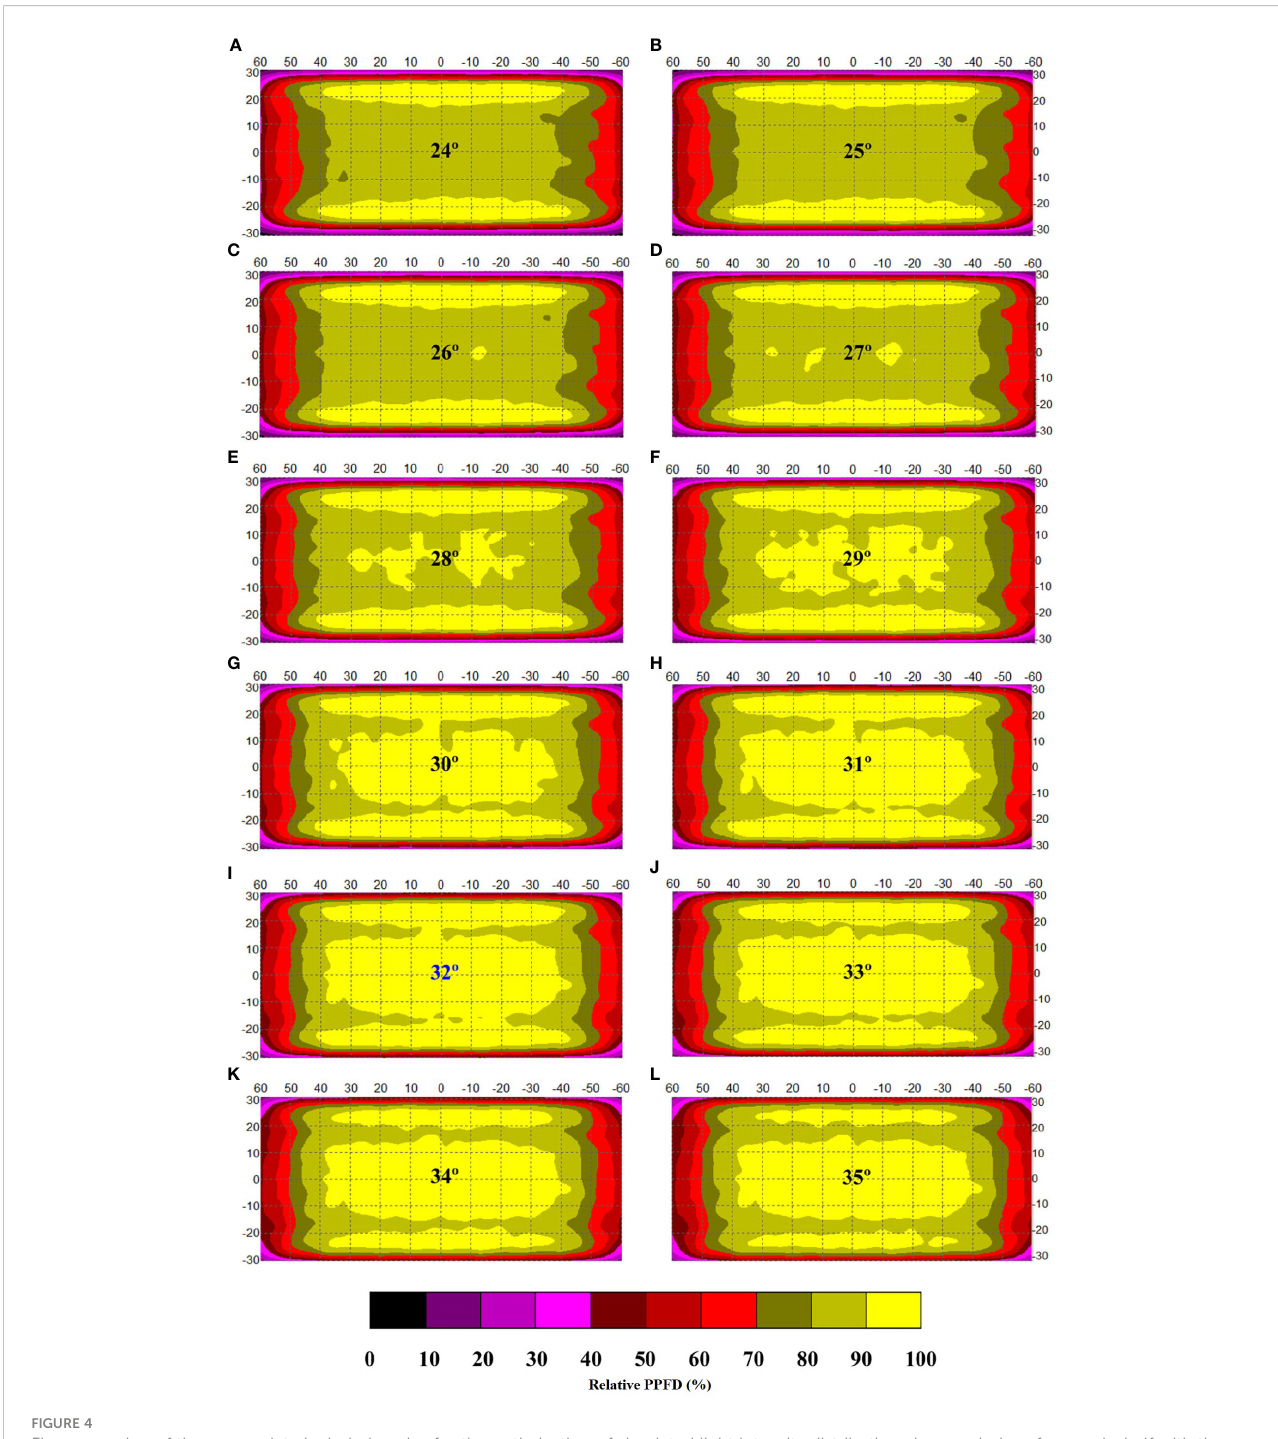
FIGURE 4 Fine-screening of the appropriate included angles for the optimization of simulated light intensity distribution along an indoor farm rack shelf with the application of an adjustable lampshade-type re fl ector. The screened included angles are (A) 24°, (B) 25°, (C) 26°, (D) 27°, (E) 28°, (F) 29°, (G) 30°, (H) 31°, (I) 32°, (J) 33°, (K) 34° and (L) 35°, respectively. The width of re fl ective board is set as 10 cm. The scale unit on the fi gure is centimeter. The numbers in the color bar indicate relative photosynthetic photon fl ux density values